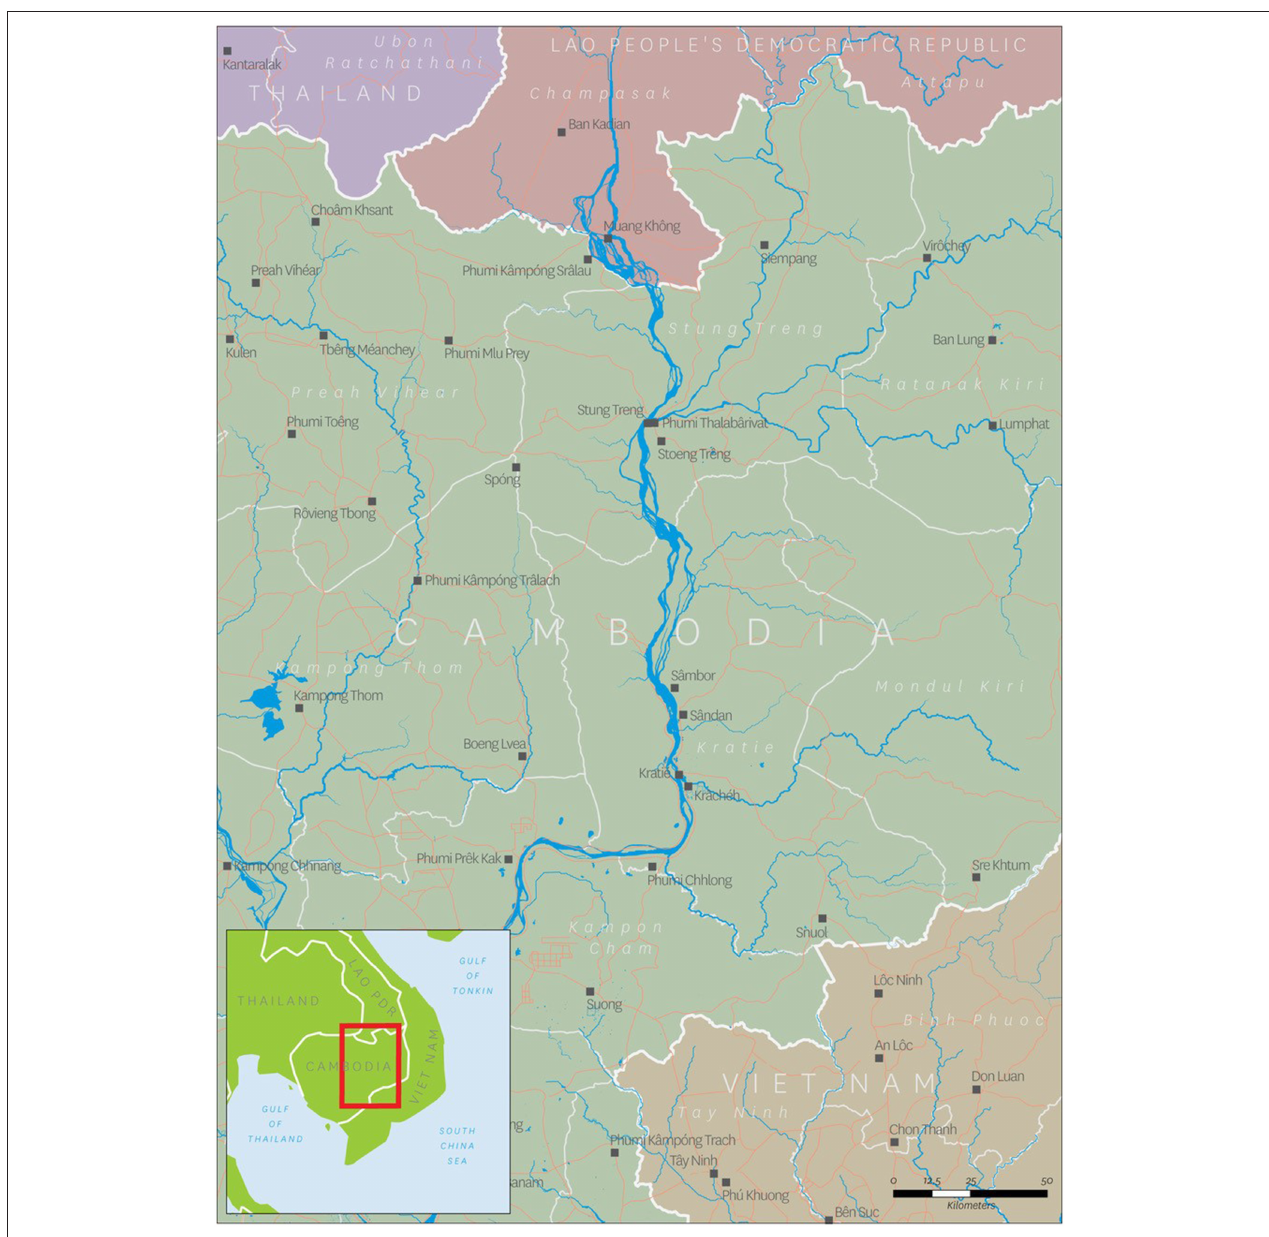
FIGURE 1 | The LIVES Cambodia study